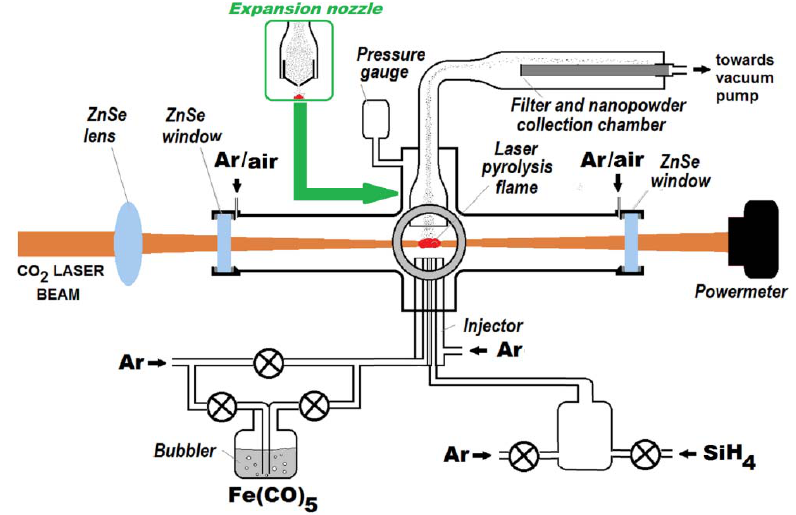
Figure 1. Experimental set-up used for the obtaining of nanometric Fe-Si-based hybrid nanoaggregates by laser pyrolysis followed by a post-irradiation superficial